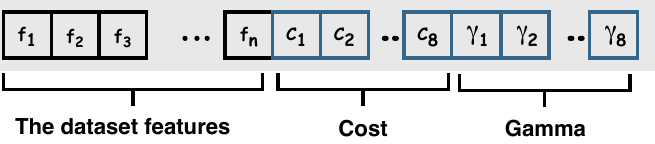
Figure 6. A vector representation of an individual salp that encompasses the features of the dataset, the hyperparameters of the KELM algorithm (C, γ ). ( n ) is the total number of features, ( C 1 − C 8 ) represent the digits of the cost value, and ( γ 1 − γ 8 ) are the digits of the γ